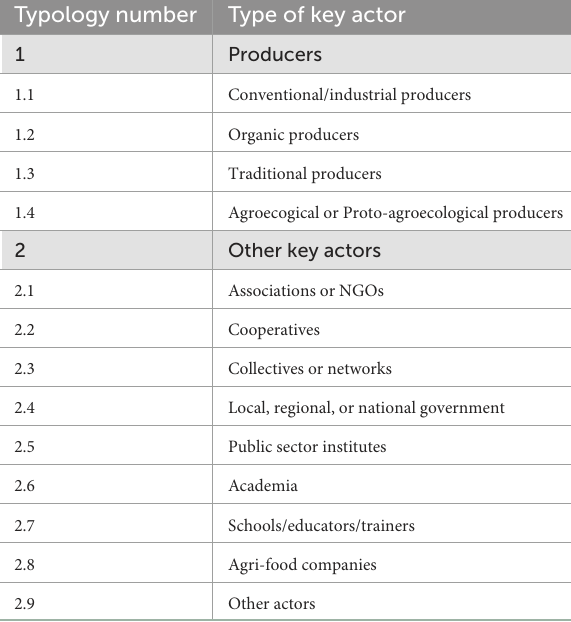
TABLE 1 List of actor typologies for the PRA. Typology